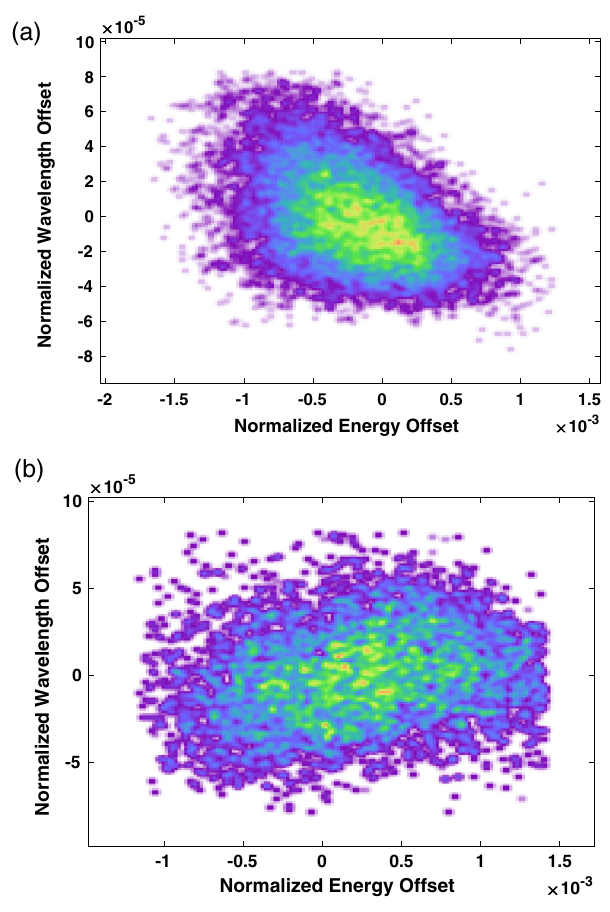
FIG. 18. False color distribution functions for the relative mean wavelength at effective undulator location U15 for the central amplified seed line as a function of relative electron beam energy, as determined from (a) 11463 individual shots of the October 2016 shift (b) 8680 shots of the June 2015